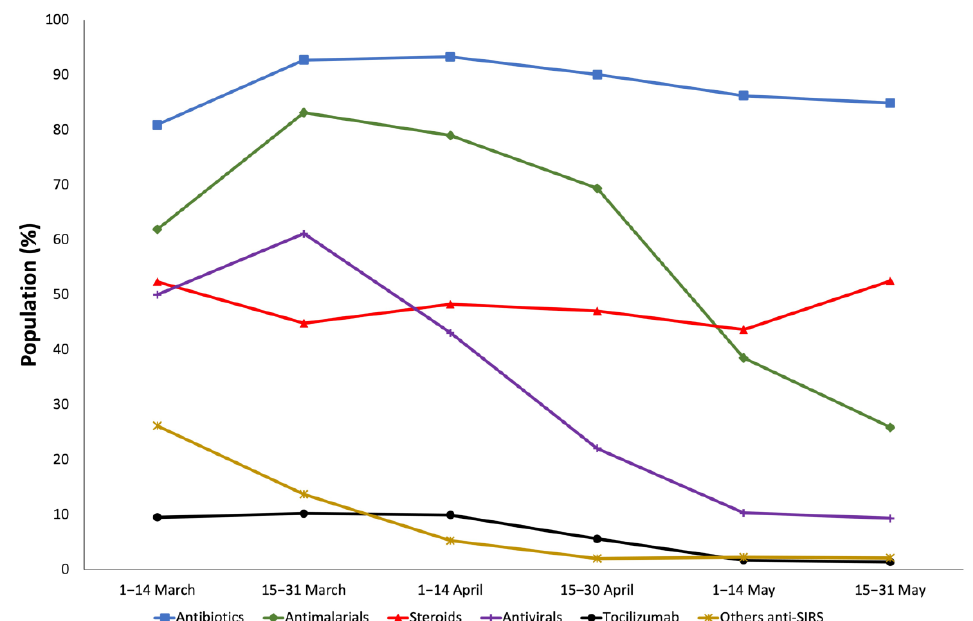
Figure 2. Therapy evolution in hospitalized COVID-19 patients with previous cardiovascular dis-